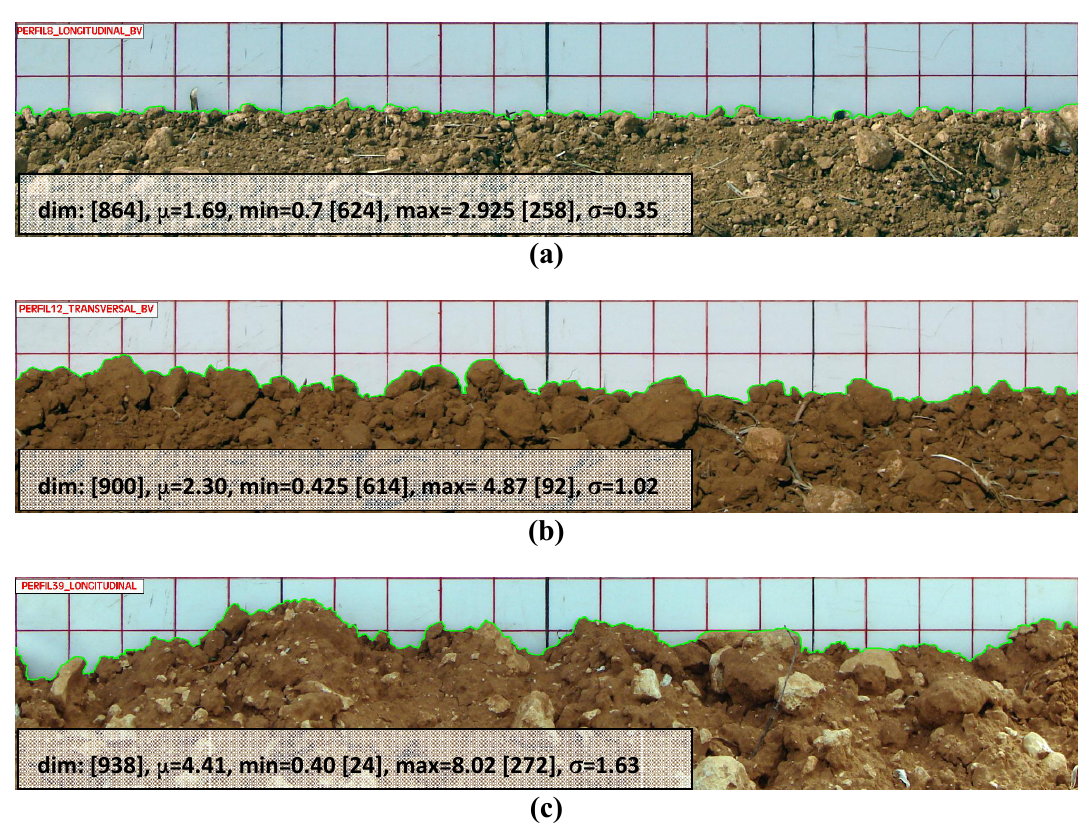
Figure 6. Example of soil roughness profiles (in green) and associated parameters (‘ dim ’: n° of points in the profile, ‘ min ’: minimum vertical displacement in cm, ‘ max ’: max. vertical displ. in cm, ‘ σ ’: height displ. standard deviation in cm), ( a ) smooth surface, ( b ) and ( c ) rough